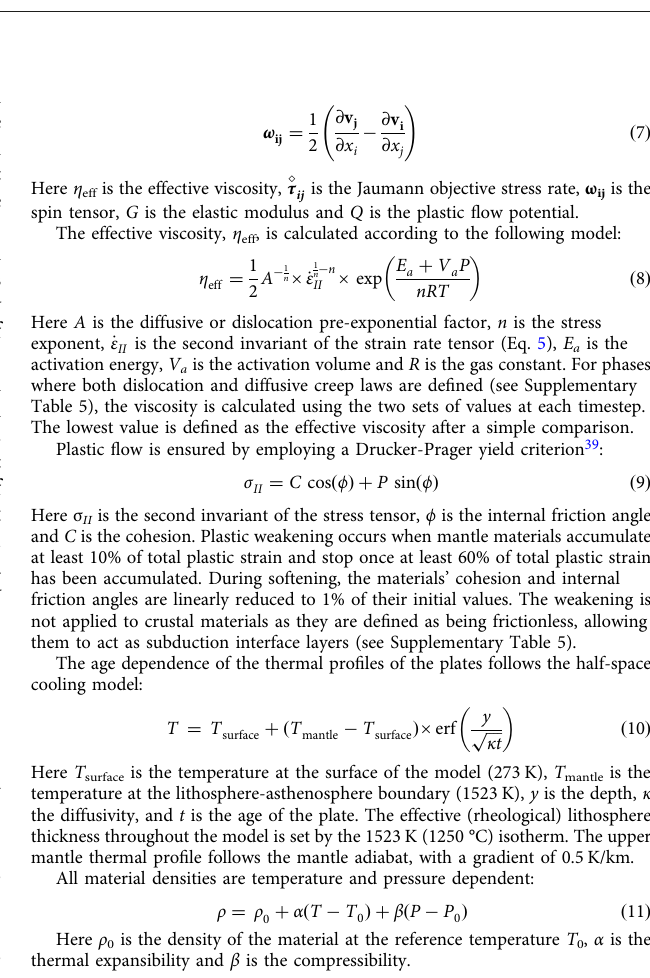
Fig. 5 Comparison between the carried-out reference model and the formation and early evolution of the Vanuatu subduction zone. a Incipient formation of the Vanuatu subduction zone. During the late Miocene, the Ontong-Java plateau (OJP) begins to dock along the Paci fi c trench triggering the initiation of the subduction of the Australian plate with opposite polarity. The currently observed cross-section along the Solomon Islands arc (inset), still allows the recognition of the incipient new subduction zone corresponding to the initial development of the Vanuatu SZ. This con fi guration is also coherently observed in the shown model (Model 1, 70 Myr overriding and subducting plate and W P = 600 km). b Formation of an extensional basin in the Paci fi c plate after the termination of the original subduction zone. The trench rollback/lateral migration of the newly formed Vanuatu subduction zone triggers extension in the new overriding plate area, forming an extensional basin ridge between this subduction zone and the Ontong-Java plateau 45 . This is consistent with our models, along the A-A ’ cross-section, where a newly formed basin is found between two subduction zones of opposite polarity. The proposed mantle in fl ow at that time 46 as well as the end of the Paci fi c subduction zone in front of the Ontong-Java plateau are also mirrored by the